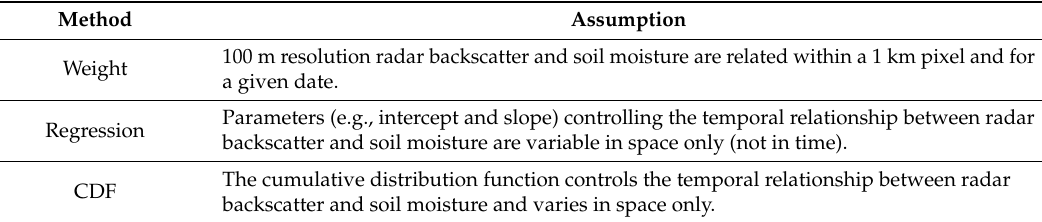
Table 1. Main assumptions of the applied methods for disaggregating the 1 km DISPATCH product to 100 m